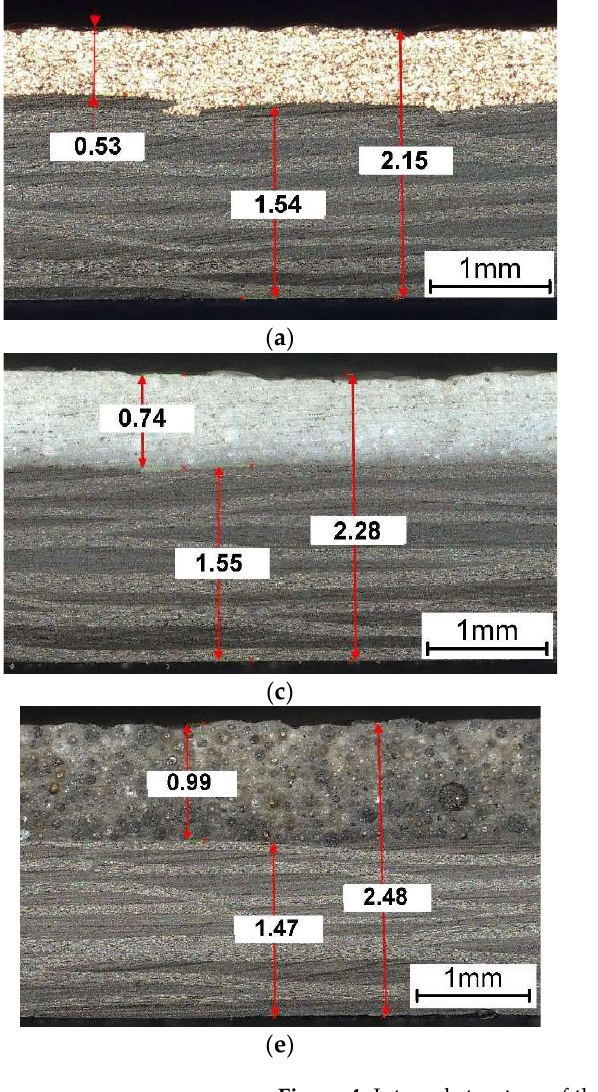
Figure 4. Internal structure of the two-layered composites consisting of the PMC substrates ( bottom ) with PLs (top) made of the following grains (dimensions are given in (mm)): ( a ) 1: copper; ( b ) 2: quartz sand; ( c ) 3: Al 2 O 3 ; ( d ) 4: aluminum; ( e ) 5: crystalline silica; and ( f ) 6: microballoon.